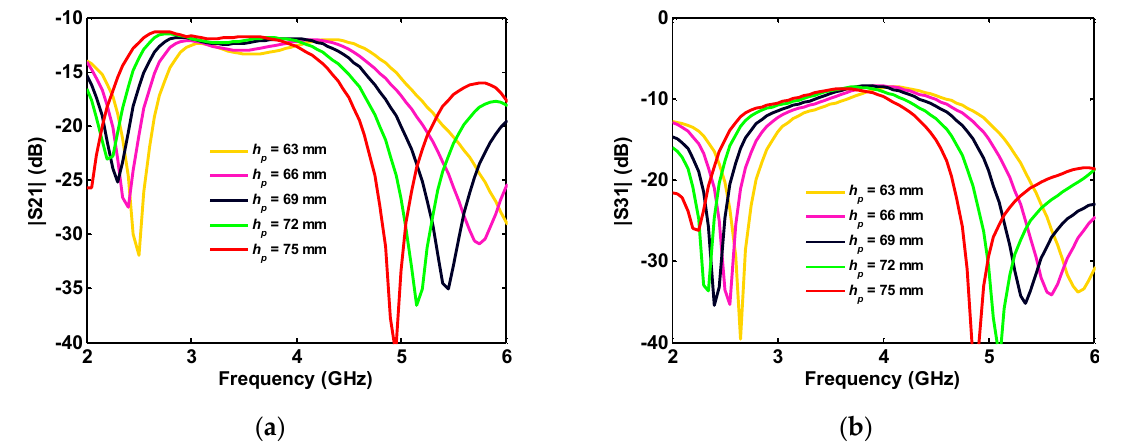
Figure 14. Effect of the ground planes height on the different ports’ isolation ( a ) S 21 and ( b ) S 31 in a four-port antenna.